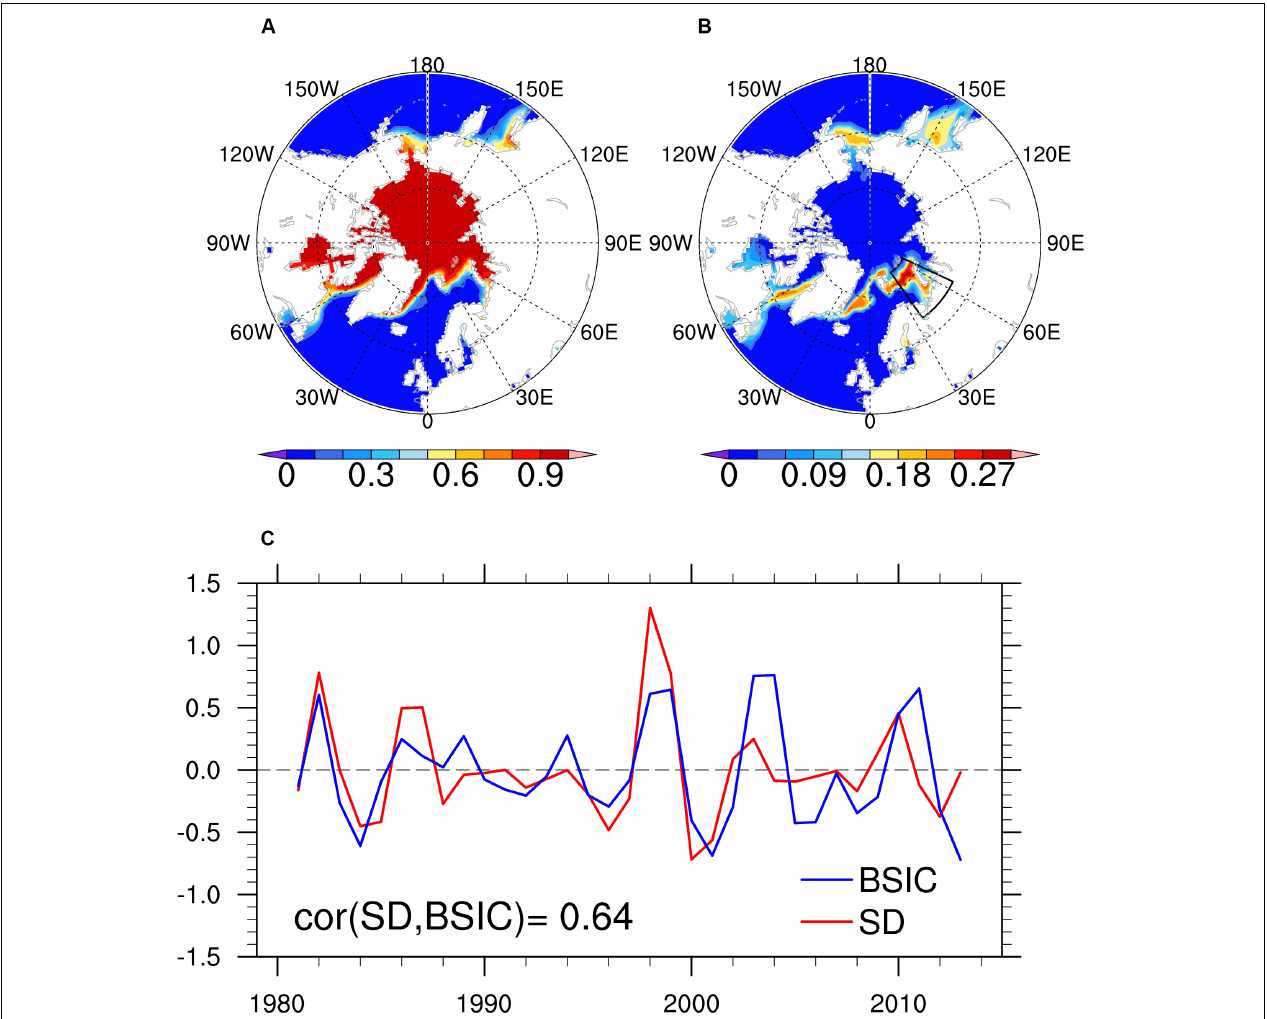
FIGURE 2 | (A) Boreal winter mean Arctic sea ice concentration; (B) the corresponding standard deviation during the period 1979–2015; and (C) the normalized time series of the domain-averaged snow depth (SD, red) over the MWTP (29 ◦ –36 ◦ N, 76 ◦ –88 ◦ E) and the Barents Sea ice concentration (BSIC, blue) in the area of (65 ◦ –80 ◦ N, 35 ◦ –65 ◦ E) as marked by the black box in B